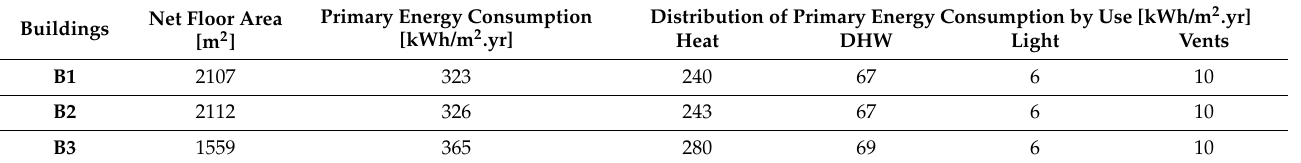
Figure 4. Top view of the housing complex. Table 1. Summary of the regulatory thermal calculations.